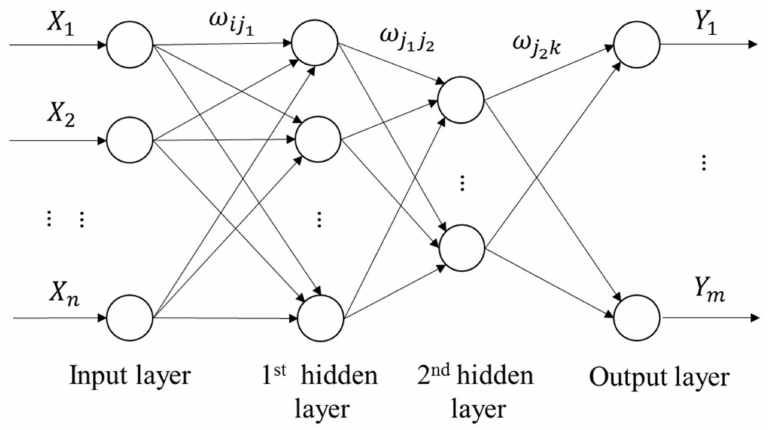
Figure 1. Back propagation neural network topology structural